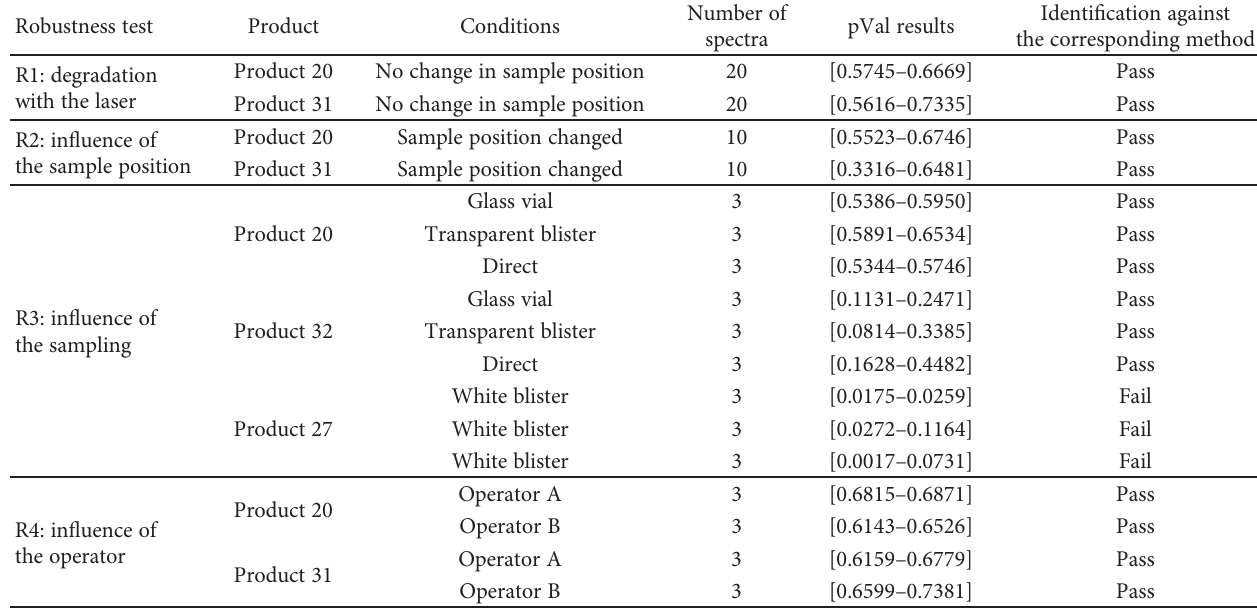
Table 4: Results of the four robustness tests. The conditions of the test, like the sampling, have been added together with the number of spectra measured. The results consist in the p value range and the pass/fail answers.